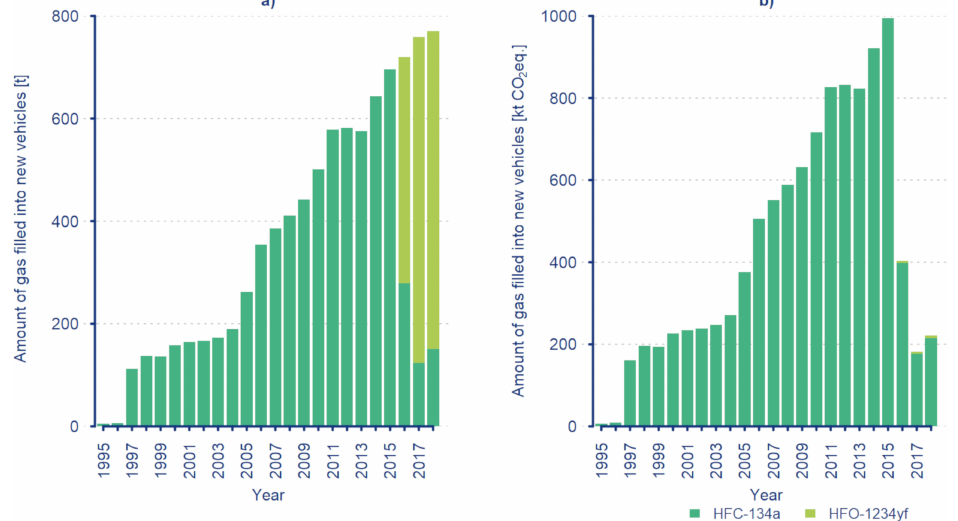
Figure 2. The trend in gases filled into new vehicles in the Czech Republic in tonnes ( a ) compared to the trend in F-gases recalculated into kt CO 2 eq ( b